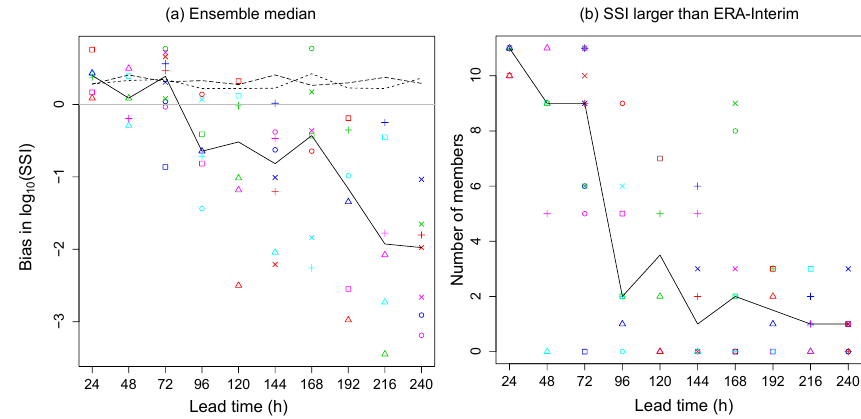
Figure 7. Severity of the storms in the ensemble reforecast on the day of maximum intensity: logarithmic difference of SSI between the ensemble median and ERA-Interim (a) and number of members reaching the SSI of ERA-Interim (b) . The symbols represent the storms as given in Table 1 and the solid black curve shows the median of the storms per lead time. The dotted and dashed black curves in (a) further show the logarithmic difference of the 95th and 99th percentiles of SSI, respectively, in the model climates of the reforecast and ERA-Interim.